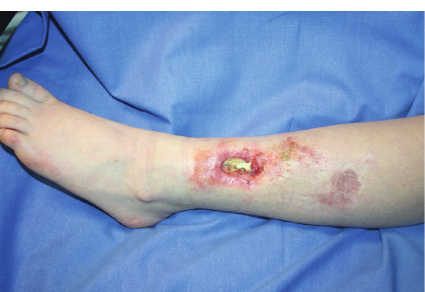
Figure 2: Leg ulcer after Ollier-Thiersch dermoepidermal graft.